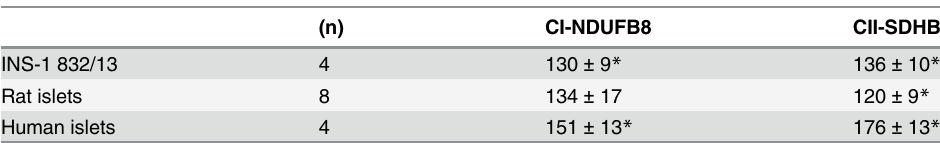
Table 6. Effect of hypoxia on mitochondrial complex protein levels. Amount of protein complex subunits I and II after hypoxia exposure(as % of protein levels at normoxia) (n) INS-1 832/13 Human islets 176 ± 13 * Complex (C) I and II subunits; NDUFB8: NADH dehydrogenase [ubiquinone] 1 beta subcomplex subunit 8, SDHB: succinate dehydrogenase subunit B. Islets from eight rats and two human donors were used for the experiments. Data are means ±